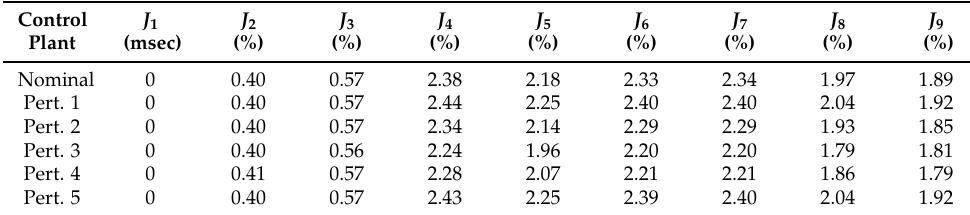
Table 9. Evaluation criteria (Damaged w/ d, El Centro earthquake, Case 3).